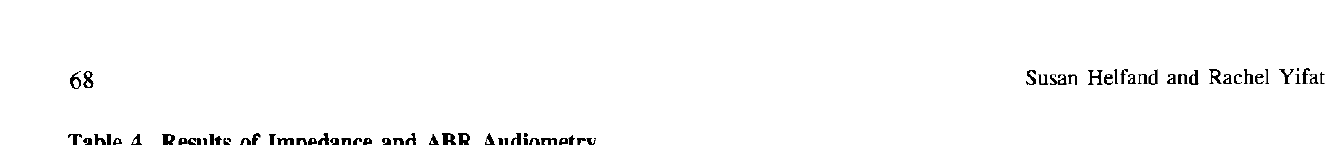
Table 4 Results of Impedance and ABR